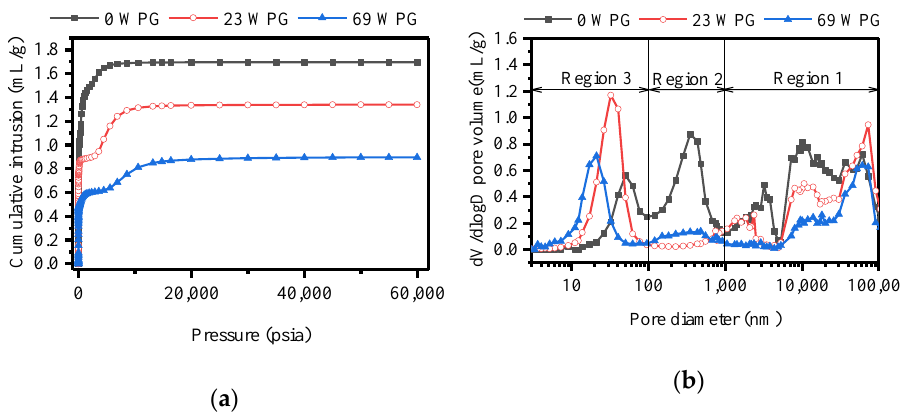
Figure 2. ( a ) Cumulative intrusion versus pressure ( b ) dV/dlogD pore volume versus pore size diameter in modified wood with different weight gain percent (WPG) (0%, 23% and 69%).